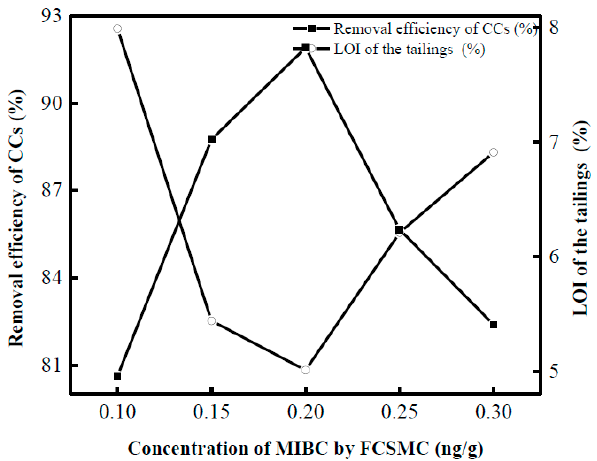
Figure 4. Effect of MIBC concentration on decarburization by FCSMC: kerosene = 3.5 g/kg·ash, Tween 80 = 7.5% of kerosene concentration, slurry concentration = 100 g/L, and pump speed = 380 r/min.